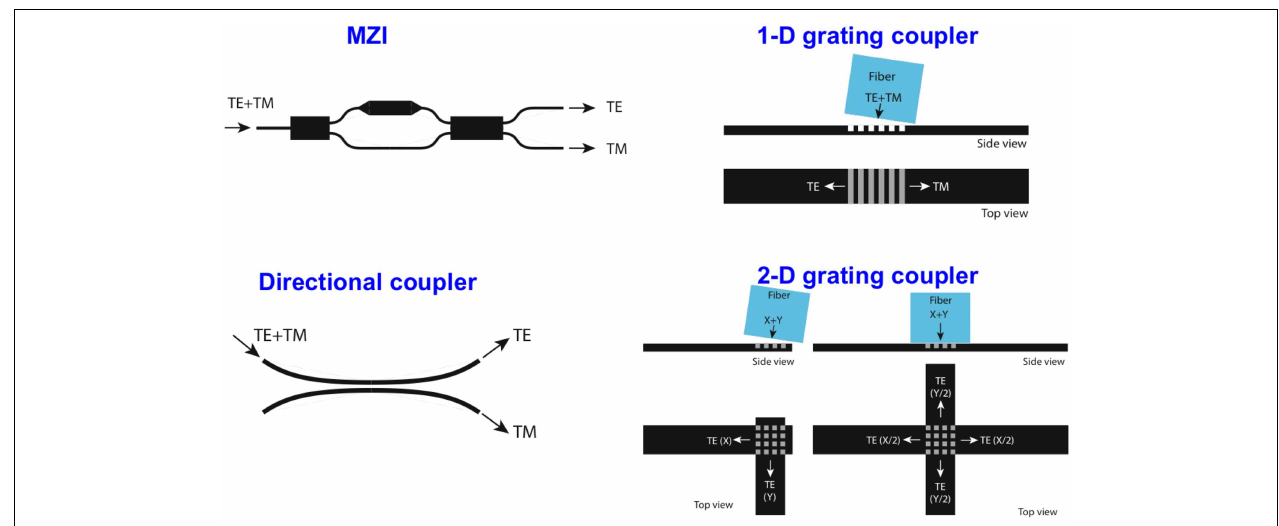
FIGURE 9 | Various polarization